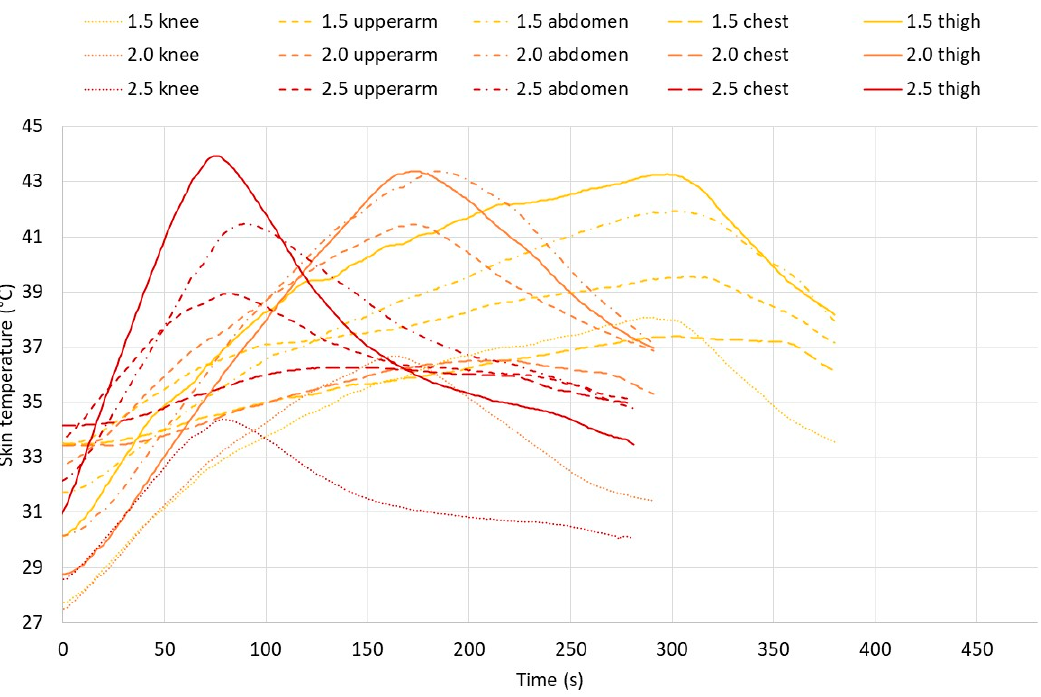
Figure 8. Skin temperatures (knee, upper arm, abdomen, chest, and thigh) of TP6 during exposure to the different radiation intensities. TP6’s exposures were terminated at 300, 166, and 76 s at 1.5, 2.0, and 2.5 kW/m 2 , respectively. Table 4. The mean ∆ Tskin/t in ◦ C/s, with standard deviation, was measured at three radiation levels at 5 body locations. Calculated over time (t = 0 until the end of exposure to the radiation panel). Skin Location 1.5 kW/m 2 2 kW/m 2 2.5 kW/m 2 Chest 0.0121 ± 0.0028 0.0158 ± 0.0073 0.0202 ± 0.0132 Table 5. Subjective responses at the start and at the end of each exposure to various radiation inten- Upper sities (mean ± SD).